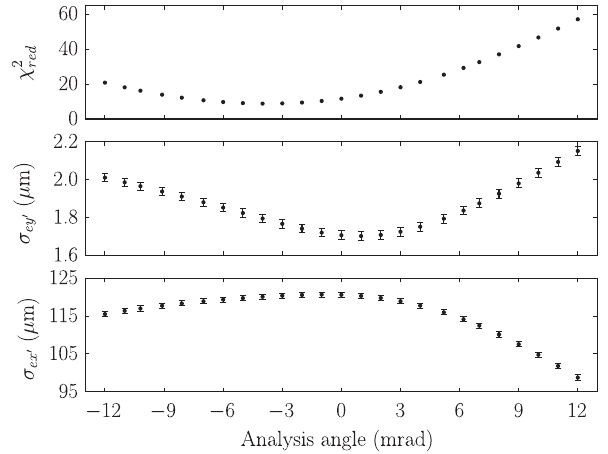
shown.FIG. 25. Comparison of analyzed vertical and horizontal sizes from rotation of combined multiple laserwire scans as well as the reduced- χ 2 for the fit in each